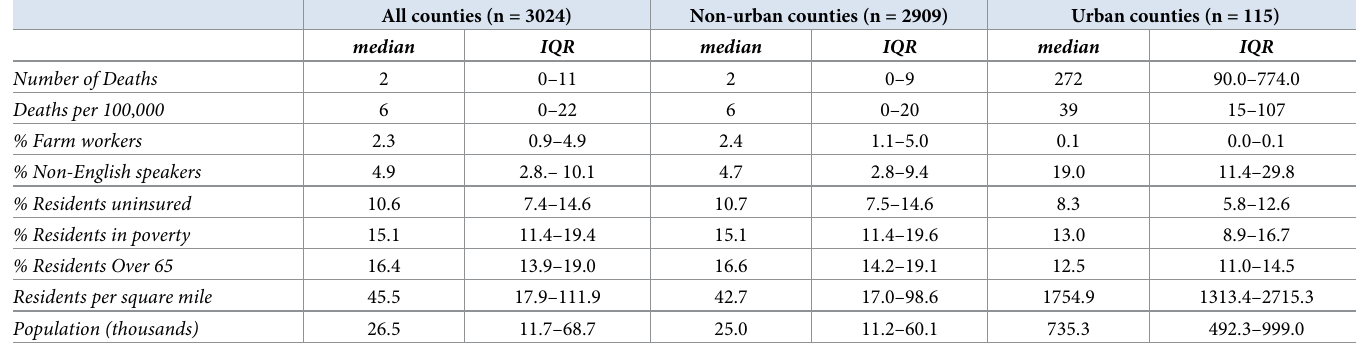
Table 1. Primary predictor and covariates of interest across all counties and stratified by urban and